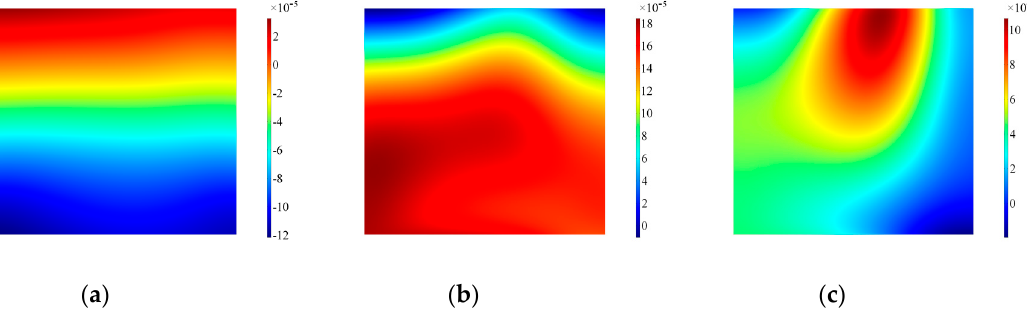
Figure 17. Surface plot for out-of-plane velocity on the alumina wear-plate, Configuration A’. Note that data are plotted at timeframes of 100 μ s ( a ), 300 μ s ( b ) and 500 μ s ( c ).